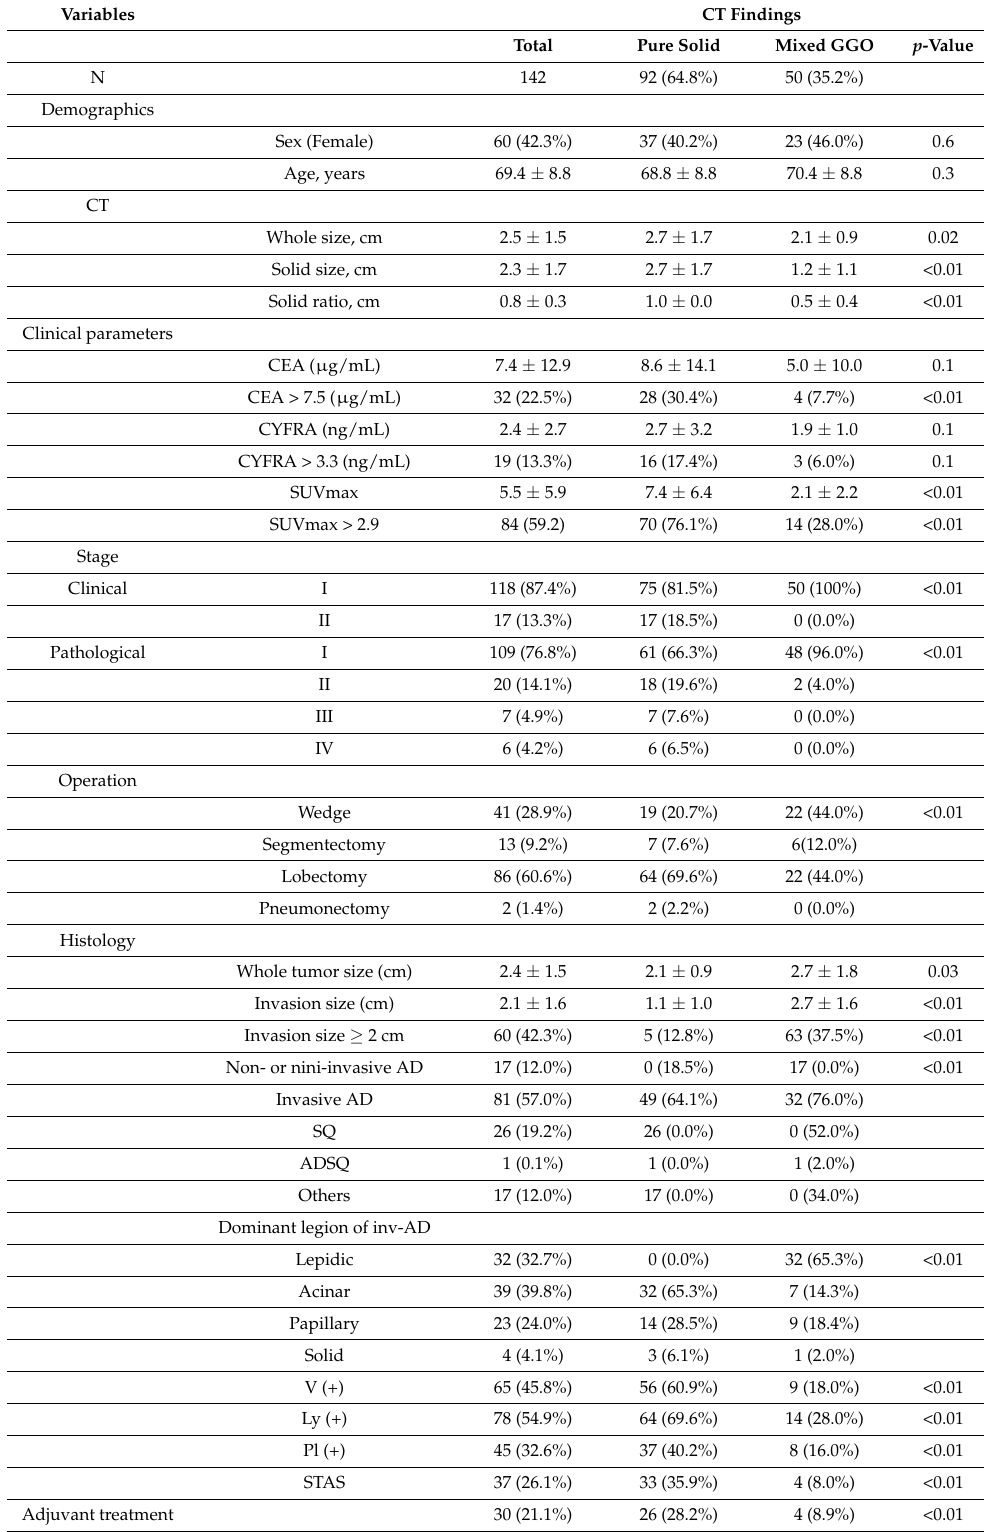
Table 1. Characteristics of the patients according to the solid patterns on computed